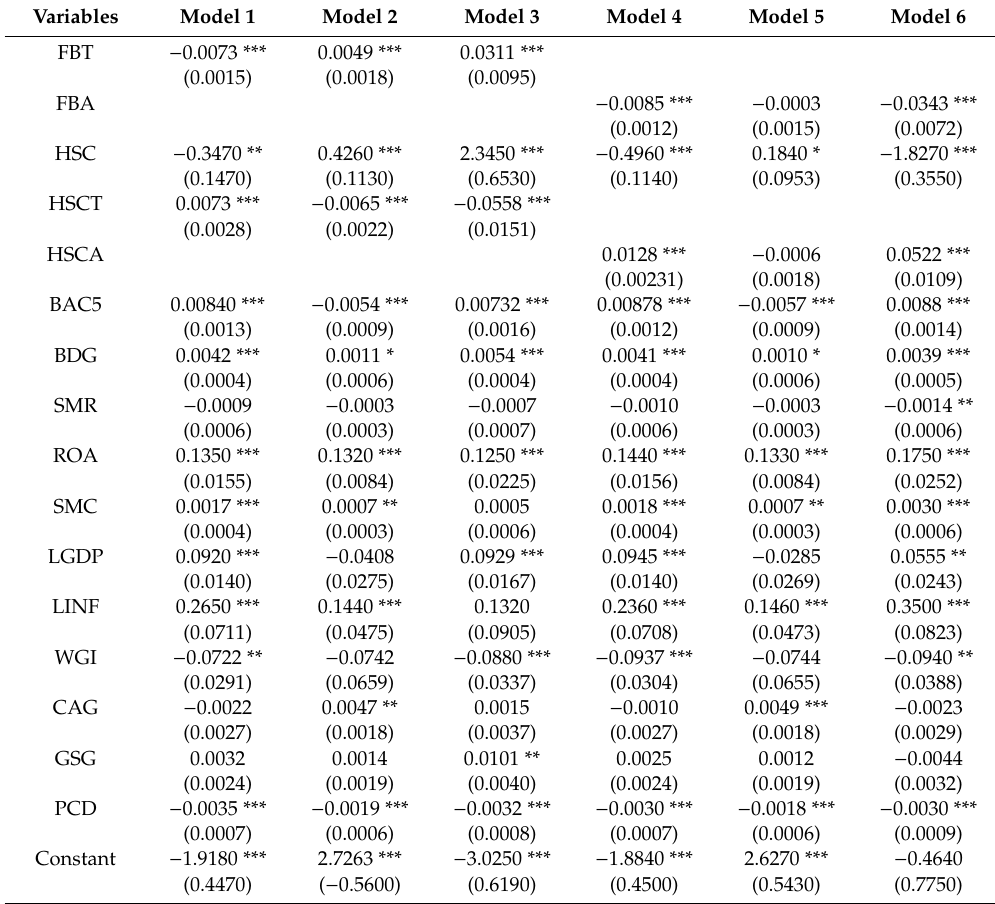
Table 3. Bank competition, foreign bank entry, and bank risk-taking behavior